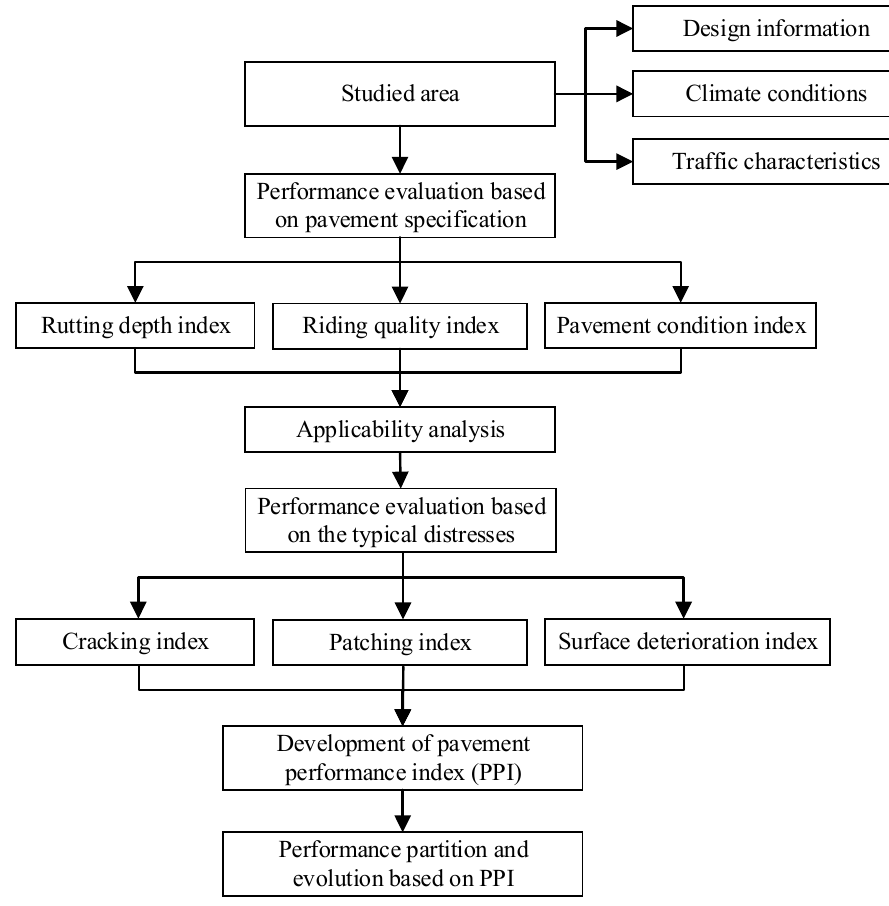
Figure 1. Organization and methodology.